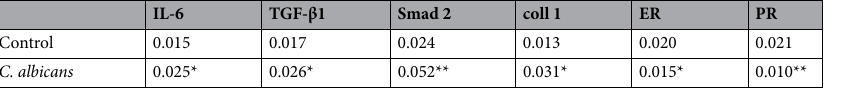
Table 4. Expression of IL-6, TGF-β1, COL1, ER, and PR in the C. albicans and control groups, as determined by IHC. ER estrogen receptor, IL-6 interleukin-6, PR progesterone receptor, TGF-β1 transforming